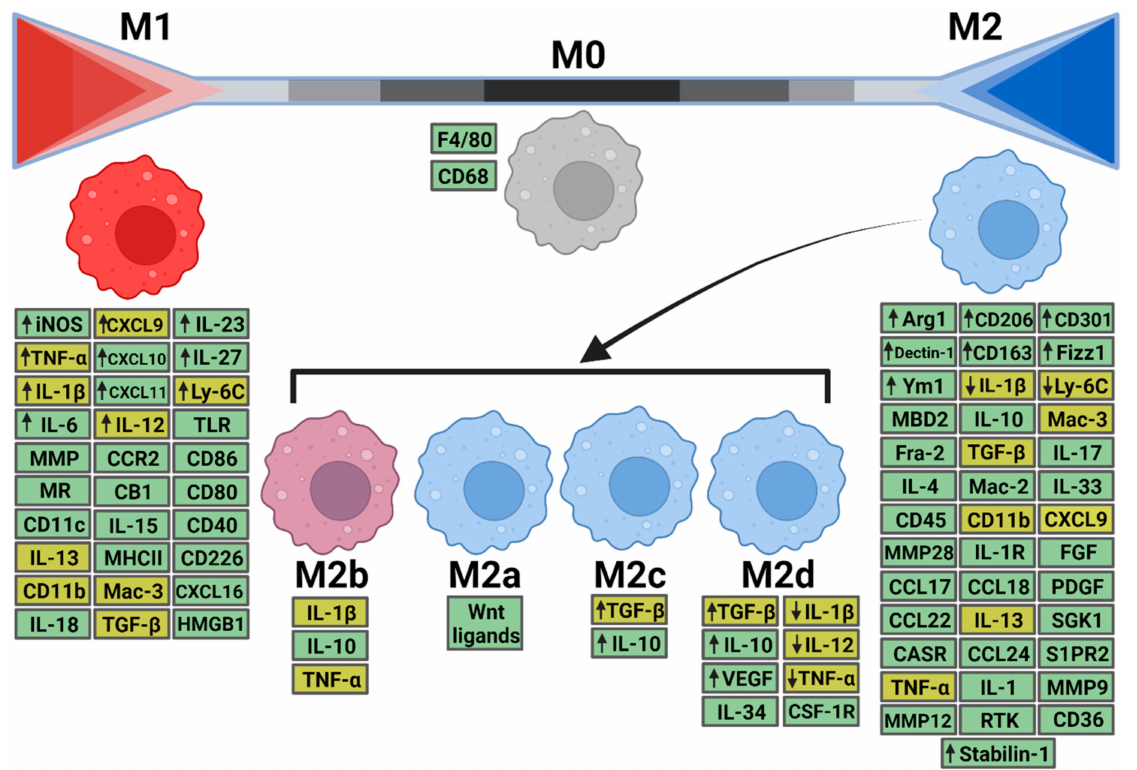
Figure 1. Presence of the main markers found in the different macrophage subtypes. Markers in light green are found in both types of macrophages (M1 and M2). Arrows indicate increased ( ↑ ) or decreased ( ↓ ) levels of the marker. Macrophage pro- inflammatory (M1), Macrophage anti-inflammatory/pro-fibrotic (M2), Inducible nitric oxide synthase (iNOS), Chemokine C-X-C motif ligand (CXCL), Interleukin (IL), Tumor necrosis factor-alpha (TNF- α ), Lymphocyte antigen 6 complex, locus C1 (Ly6C), Toll-like receptor (TLR), Matrix metalloproteinase (MMP), CD (Cluster of differentiation), Mineralocorticoid receptor (MR), Cannabinoid receptor 1 (CB1), Class II major histocompatibility complex (MHCII), Transforming Growth Factor-beta (TGF- β ), High-mobility group box-1 (HMGB1), Arginase 1 (Arg1), Mannose receptor 1 (CD206), Resistin-like protein α (Fizz1), Methyl-CpG-binding domain 2 (MBD2), Fos-related antigen-2 (Fra-2), Fibroblast growth factor (FGF), Chemokine C-C motif ligand (CCL), Platelet derived growth factor (PDGF), Serum/Glucocorticoid Regulated Kinase 1 (SGK1), Class A scavenger receptor (CASR), Sphingosine-1-phosphate receptor-2 (S1PR2), Receptor tyrosine kinases (RTK), Vascular endothelial growth factor (VEGF), Colony-stimulating factor-1 receptor